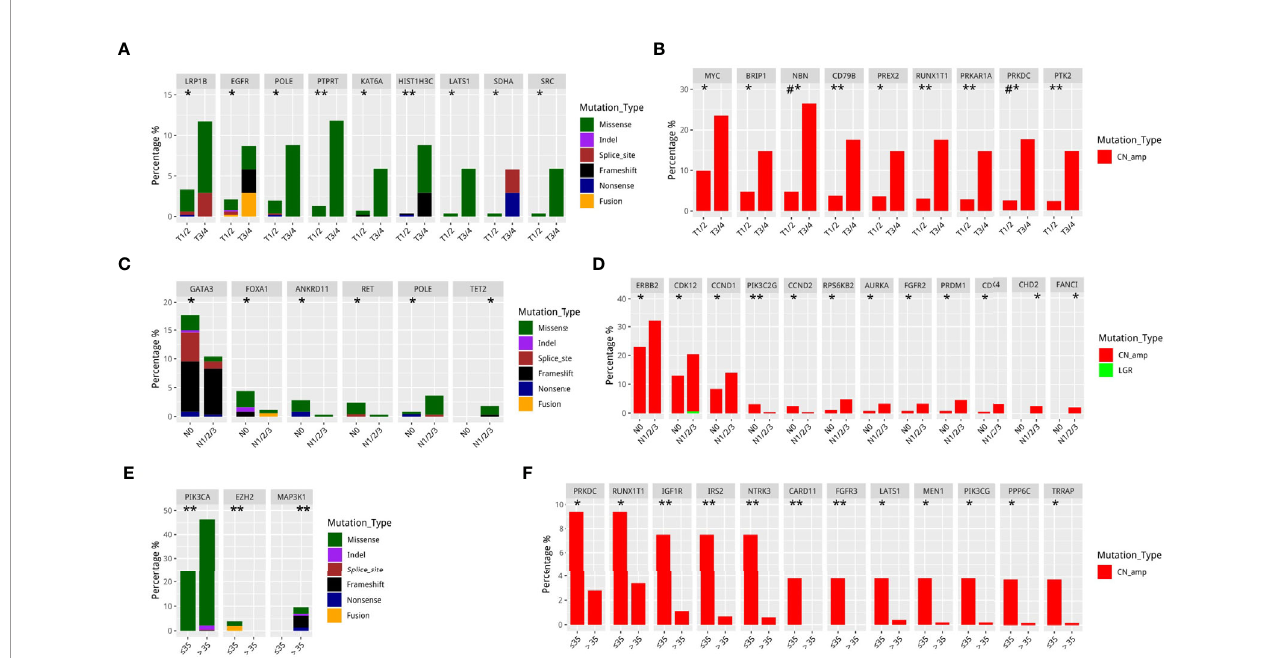
FIGURE 2 | Differentially mutated genes in different Tumor stage, Nodal stage, and younger breast cancer in GDPH cohort. (A, B) Differentially mutated (SNV/Indel/ fusion) (A) and ampli fi ed (B) genes among T1 – 2 and T3 – 4 breast cancer. (C, D) Differentially mutated (SNV/Indel/fusion) (C) and ampli fi ed (D) genes among patients based on the presence and absence of lymph node metastasis. (E, F) Differentially mutated (SNV/Indel/fusion) (E) and ampli fi ed (F) genes between younger ( ≤ 35 years) and older (>35 years) patients with breast cancer. * P <0.05; ** P ≤ 0.01; # P ≤